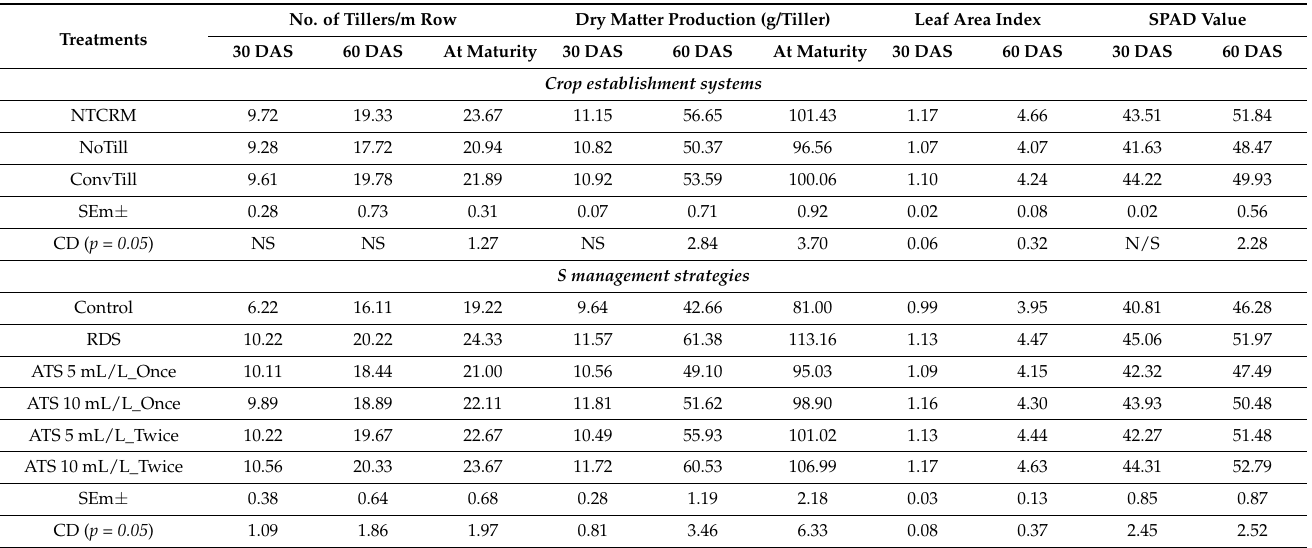
Table 1. Effect of crop establishment system and sulphur nutrition levels on growth parameters of pearl millet (mean of two years of